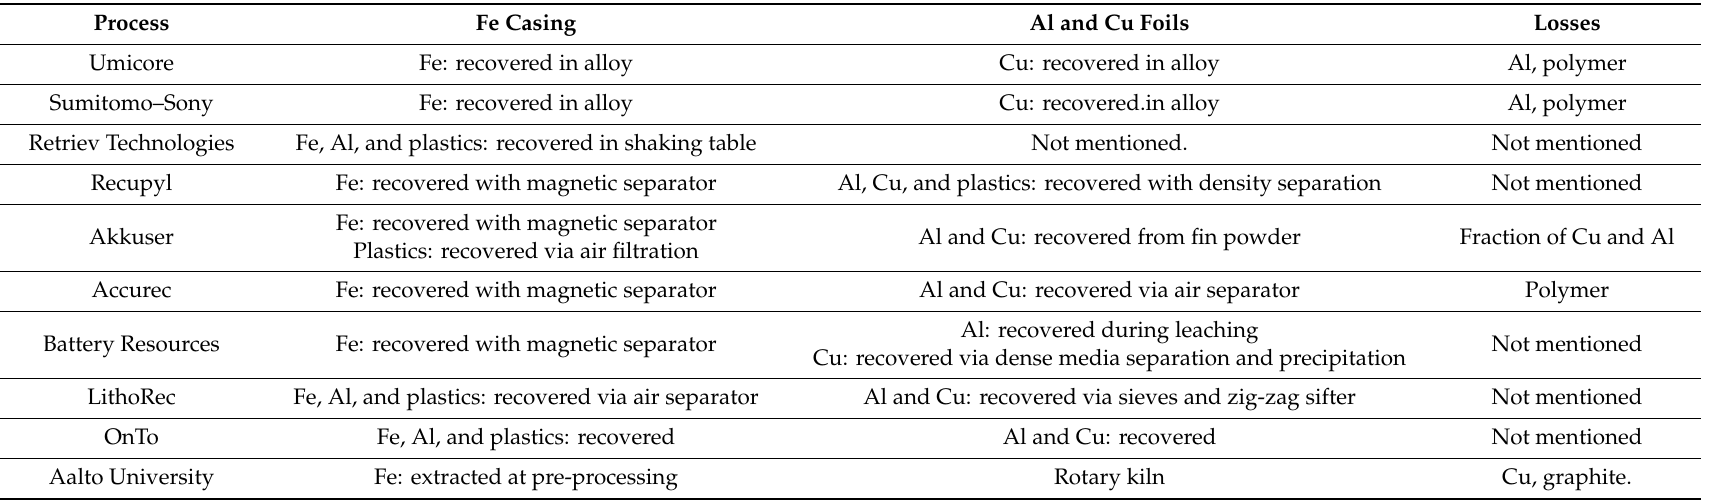
Table 5. Metal recovery summary of the recycling